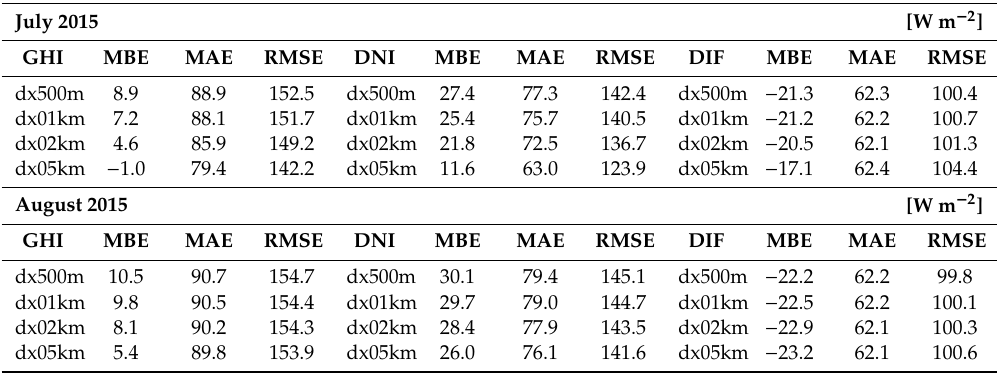
Table 2. Forecast errors metrics (MBE, MAE, and RMSE) for GHI (left), DNI (center), and DIF (right) for Exp-Summer (July (upper tables) and August (lower tables)) in 2015.The forecasts with 00 UTC (09 JST) initialization time are shown. Model set-up for numerical experiments with four di ff erent horizontal